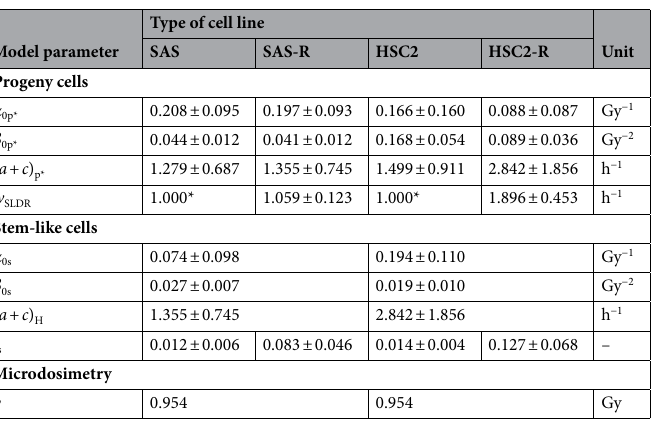
Table 1. Model parameters for predicting cell surviving fraction of SAS families and HSC2 families. *The w SLDR is the ratio of ( a + c ) H to ( a + c ) p* of non-radioresistant cell lines (SAS, HSC2), so the value of SAS and HSC2 is unity.